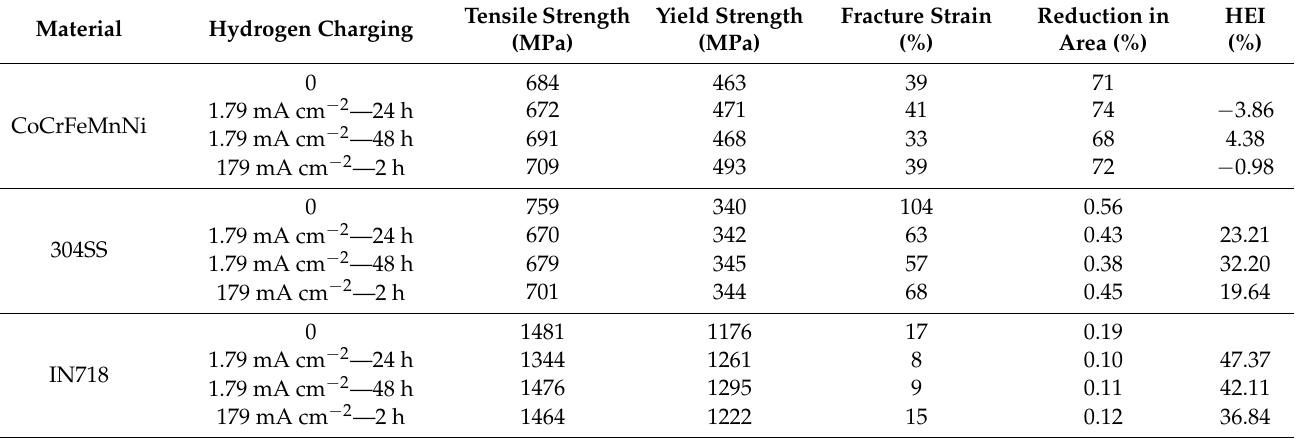
Table 2. Mechanical properties of hydrogen-charged and uncharged samples of CoCrFeMnNi, 304SS, and IN718